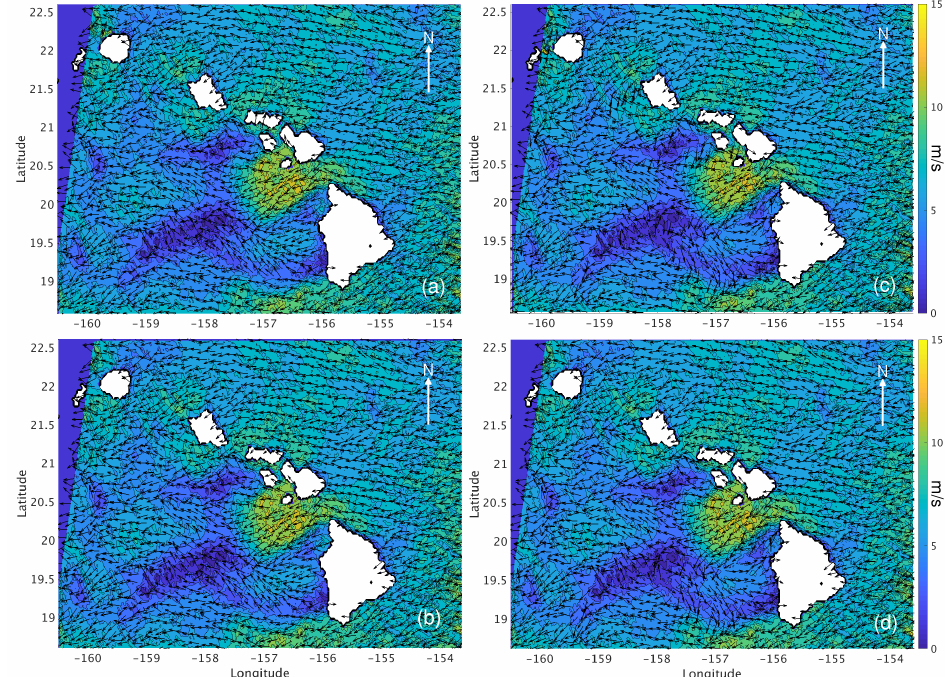
Figure 9. Simulated HRCM wind field nudged with an L2B field ( a ), simulated field nudged with L2B and median filtered ( b ), simulated field nudged with the true field ( c ), simulated field nudged with true field and median filtered ( d ). The median filter window size is 42.5 km (17 x 17 UHR WVC). Downsampled wind direction quivers are shown in all panels.